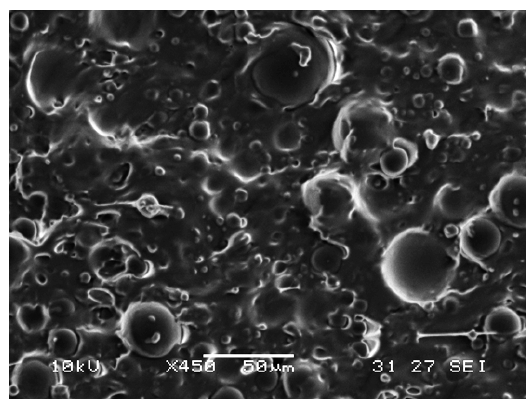
Figure 3. Typical scanning electron microscope (SEM) image of SPPM4. The scale bar is 50 µm.